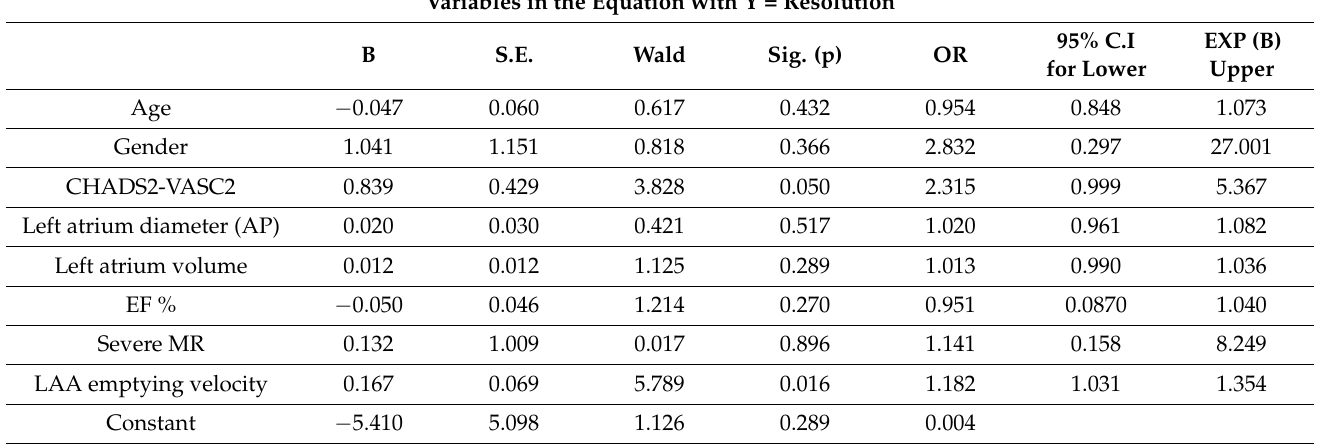
Table 4. Variables entered on logistic regression: age, gender, CHADS2-VASC2, left atrium diam- eter (AP= antero-posterior), left atrium volume, EF % (ejection fraction), Severe MR (MR = mitral regurgitation), LAA emptying velocity (LAA= left atrial